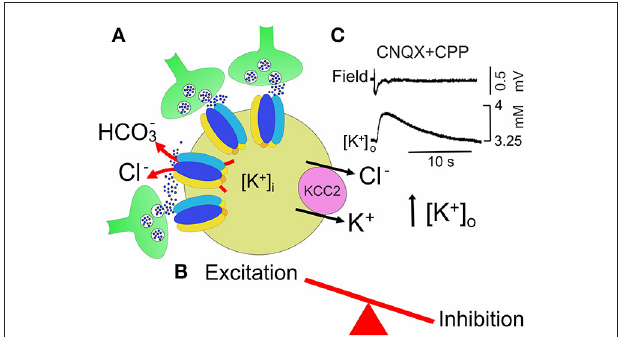
FIGURE 5 | In the 4-AP model of MTLE, neuronal synchronization preceeding ictal dischages, may occur in the absence of glutamatergic transmission. (A) GABA, abundantly released from GABAergic interneurons (green) which make synapses with a principal cell (yellow), binds to GABA A receptor-channels, permeable to chloride and HCO − 3 . HCO − 3 permeability would allow to shift the equilibrium potential for GABA (E GABA ) toward more positive values respect to E Cl − . The high firing rate of GABAergic interneurons, electrically coupled via gap junctions, leads to accumulation of K + in the extracellular space (high [K + ] o ), which is instrumental in triggering ictal activity. By producing a further shift of E GABA toward more positive potentials, high [K + ] o contributes to weaken inhibition. In addition, activation of GABA A receptors would cause an inward flux of Cl − that would activate the cation-chloride exporter KCC2. By extruding both Cl − and K + , this would further enhance neuronal excitability by further rising [K + ] o (B) . (C) Field potential recording of a slow GABAergic event due to the synchronous activation of GABA A receptors (slow GABAergic spike) preceeding elevation of extracellular K + measured with ion-sensitive electrodes in the presence of AMPA and NMDA receptor antagonists, CNQX and CPP, respectively (modified from Avoli et al.